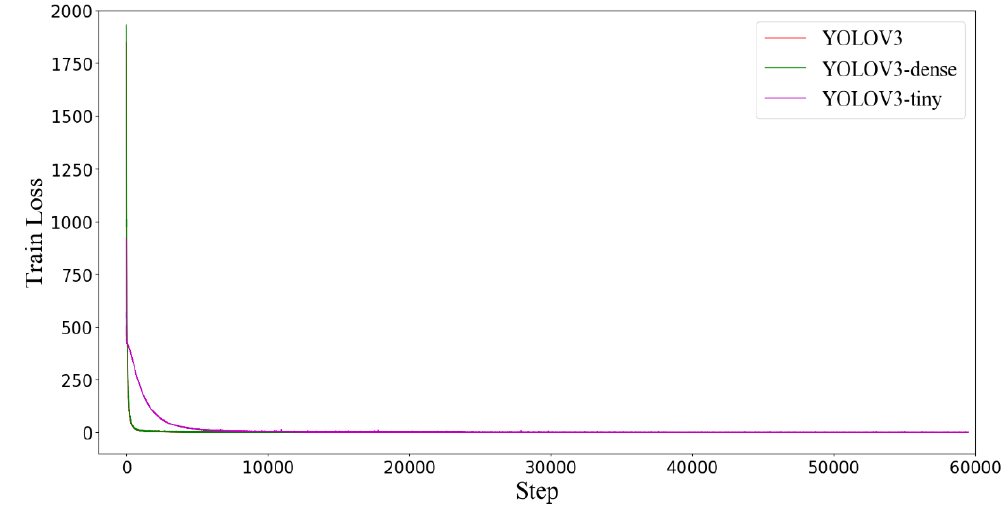
Figure 8. Loss curves of the proposed model and other YOLO series comparison models.